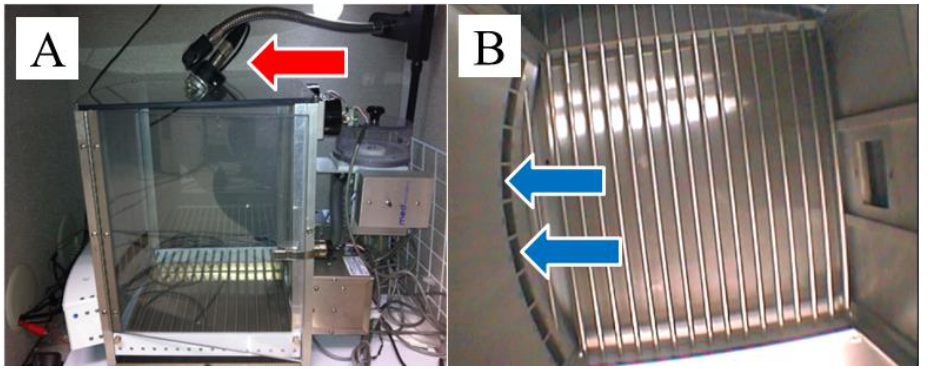
Figure 1. The operant chamber used for the experiment A) Side view of the apparatus. The red horizontal arrow indicates the ultrasound microphone. The microphone was inserted in the center hole at the chamber roof. B) Top view. Blue horizontal arrows indicate the location of the lit nose poke holes during the differential conditioning